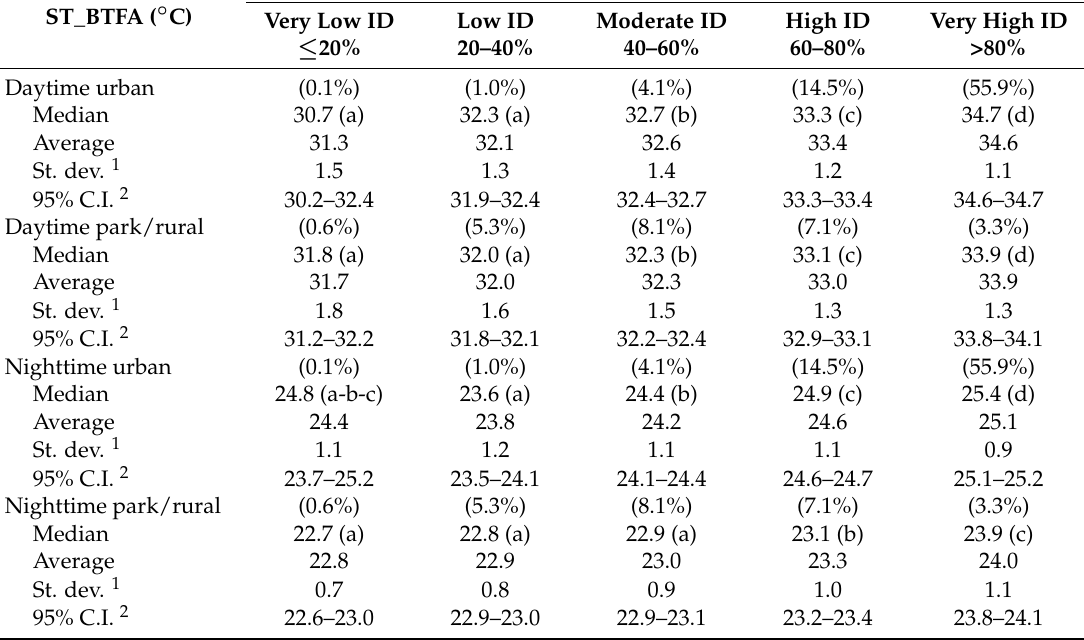
Table 2. Descriptive statistic of daytime (30 June 2015) and nighttime (25 June 2016) surface temperatures nearby residential buildings (ST_BTFA) observed in different urban and park/rural imperviousness density (ID) groups. The percentage of residential buildings involved in each urban and park/rural ID group is indicated in round brackets. Different letters in round brackets indicate significant ( p < 0.05) differences between ID